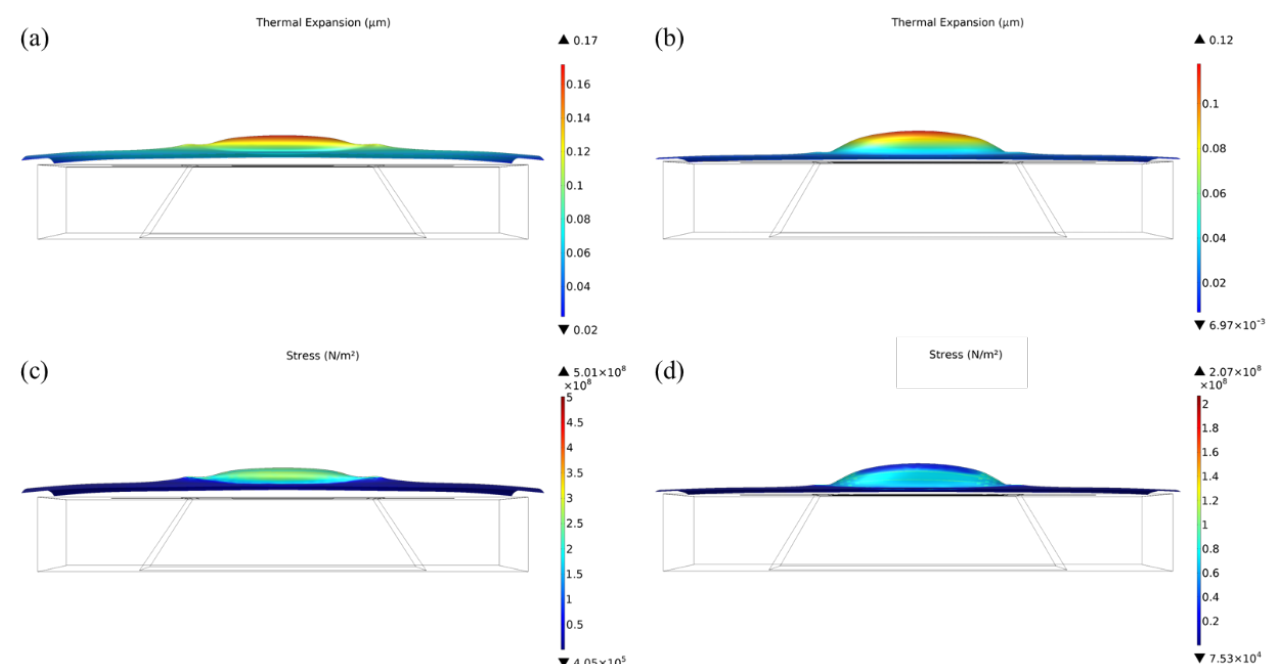
Figure 6. Thermal expansion and stress while heating to 400 ◦ C: ( a , c ) microhotplate with conventional planar structure; ( b , d ) microhotplate with a 20 µ m compensation structure.